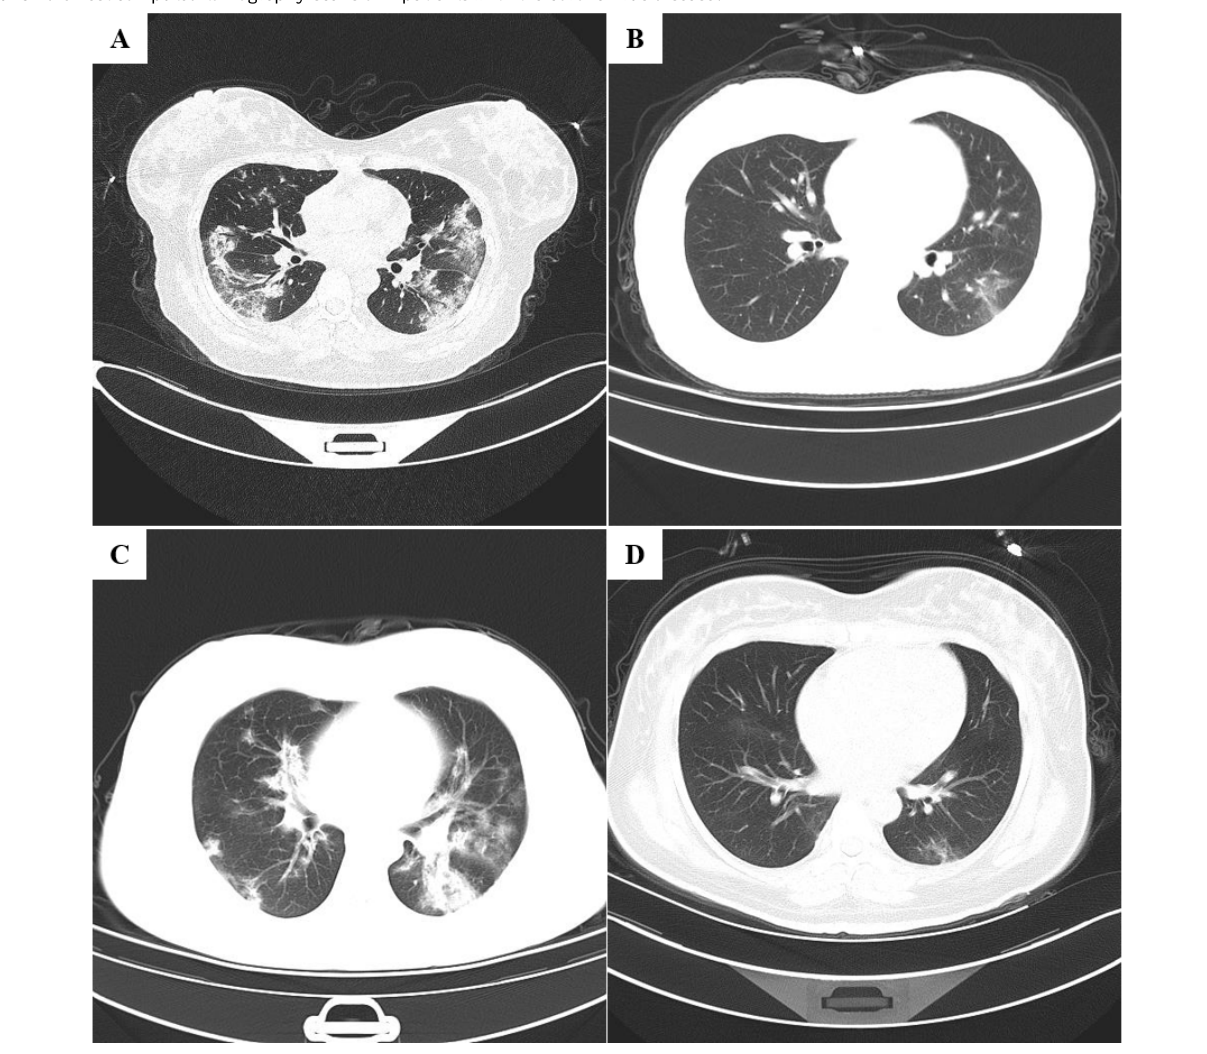
Figure 1. Chest computed tomography scans of 4 patients with the coronavirus